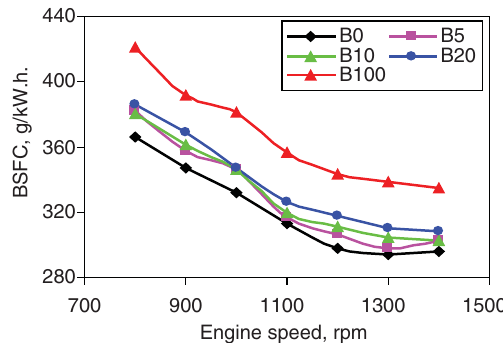
Fig. 7. The effect of the tested fuels on the brake specific fuel consumption with different engine speed